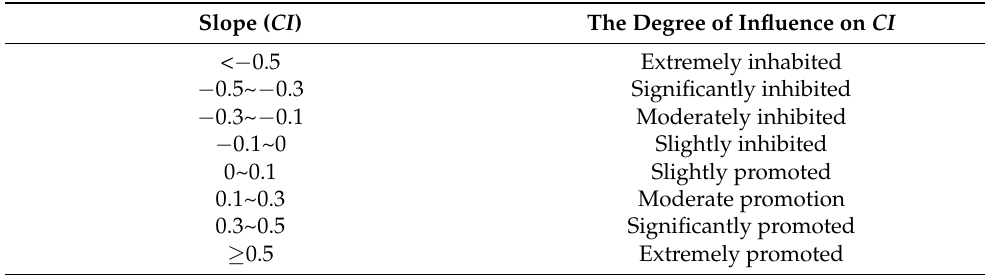
Table 1. Grading of the degree of CI being affected.